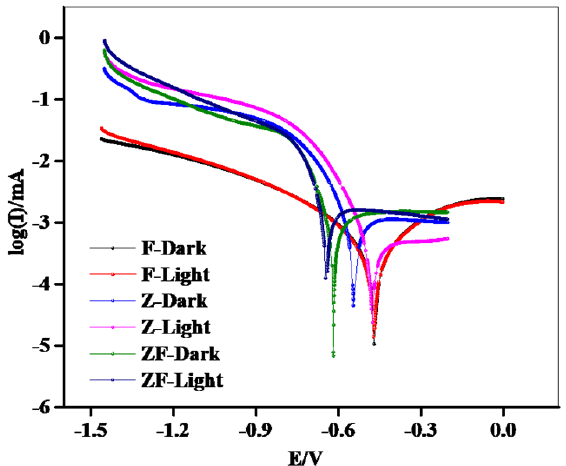
Figure 7. Tofel plots of ZnFe 2 O 4 (Z), Fe 2 O 3 (F), and ZnFe 2 O 4 -Fe 2 O 3 (ZF) nanostructures under light ON/OFF states in 0.1 M KOH electrolyte. Table 2. Tafel analysis of the synthesized anodes under light ON/OFF states in 0.1 M KOH electrolyte.